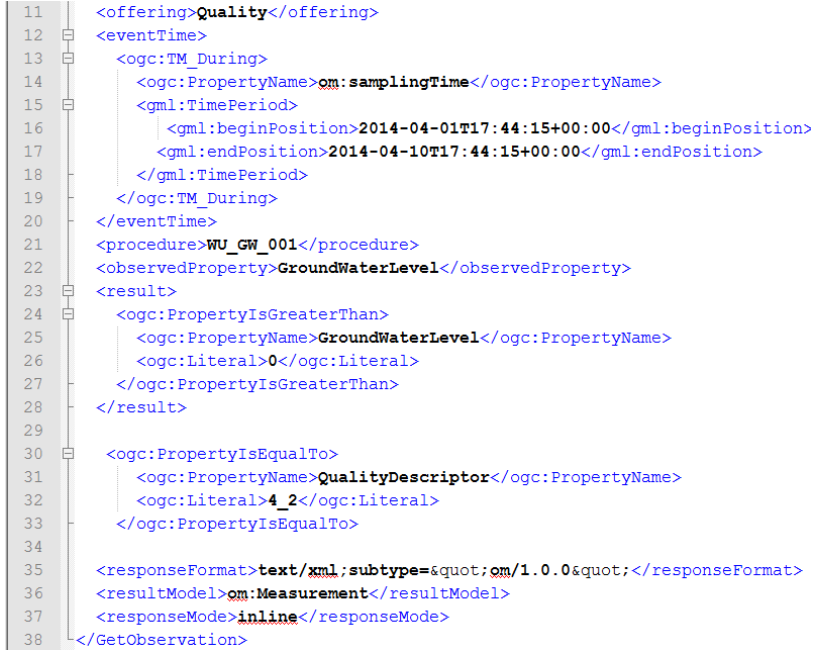
Figure 5. Excerpt of an GetObservation request containing a result filter based on quality